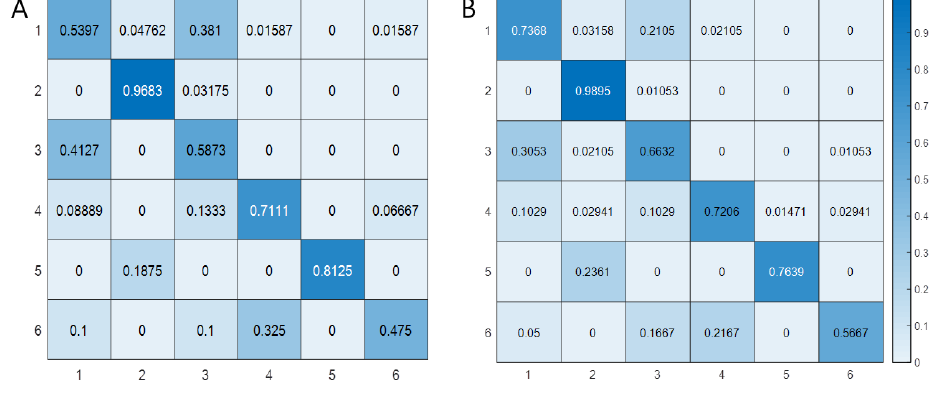
Figure 3. Confusion matrix of the training data set ( A ) and test data set ( B ). The average accuracy of the training set ( A ) is 0.72, and that of the test set ( B ) is 0.68. The corresponding average precision is 0.71 and 0.77, respectively, the average recall is 0.69 and 0.74, respectively, and the F1 score is 0.70 and 0.75, respectively.